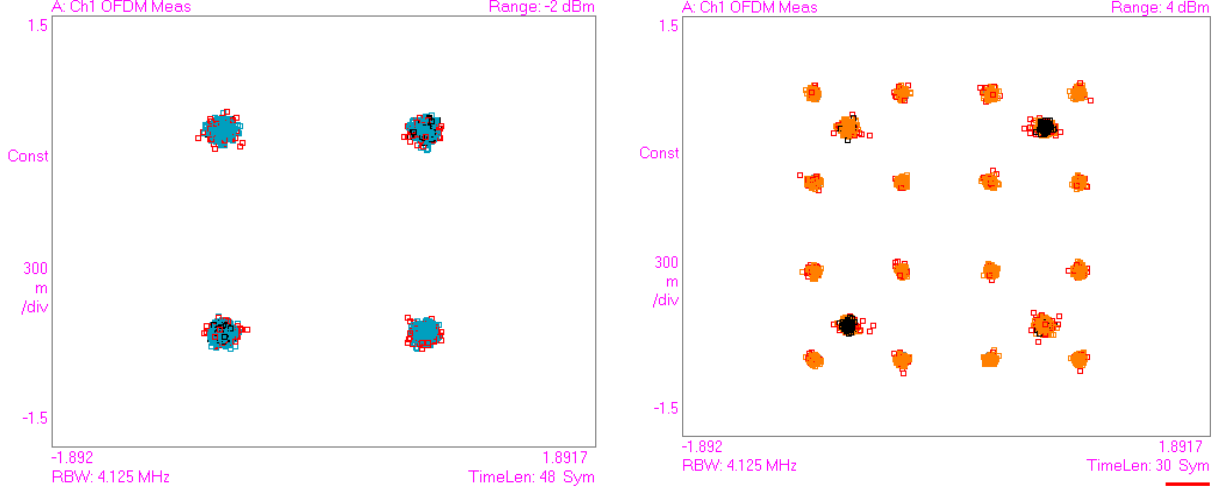
fiber) and the fiber